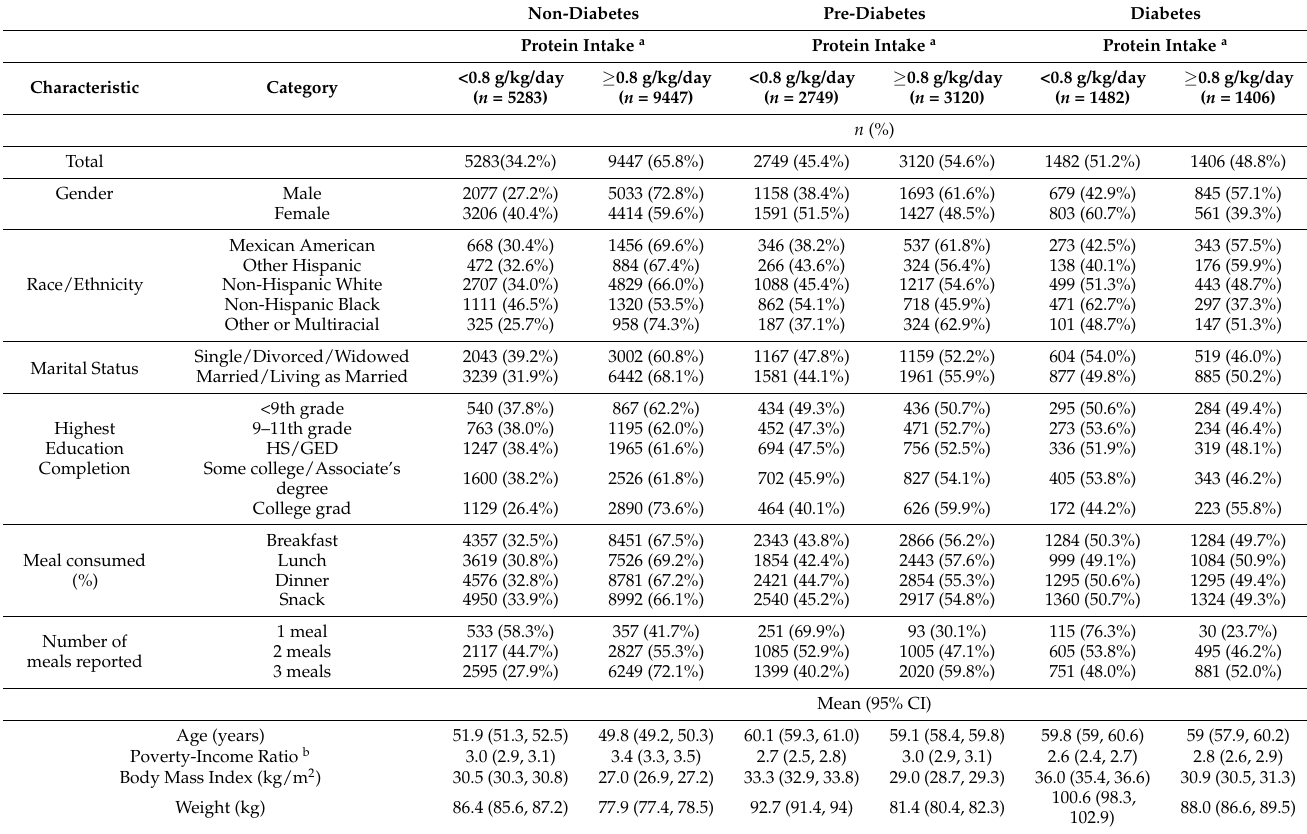
Table 1. Personal and demographic characteristics in US adults by diabetes status, stratified by intakes above or below protein intake recommendations from the dietary